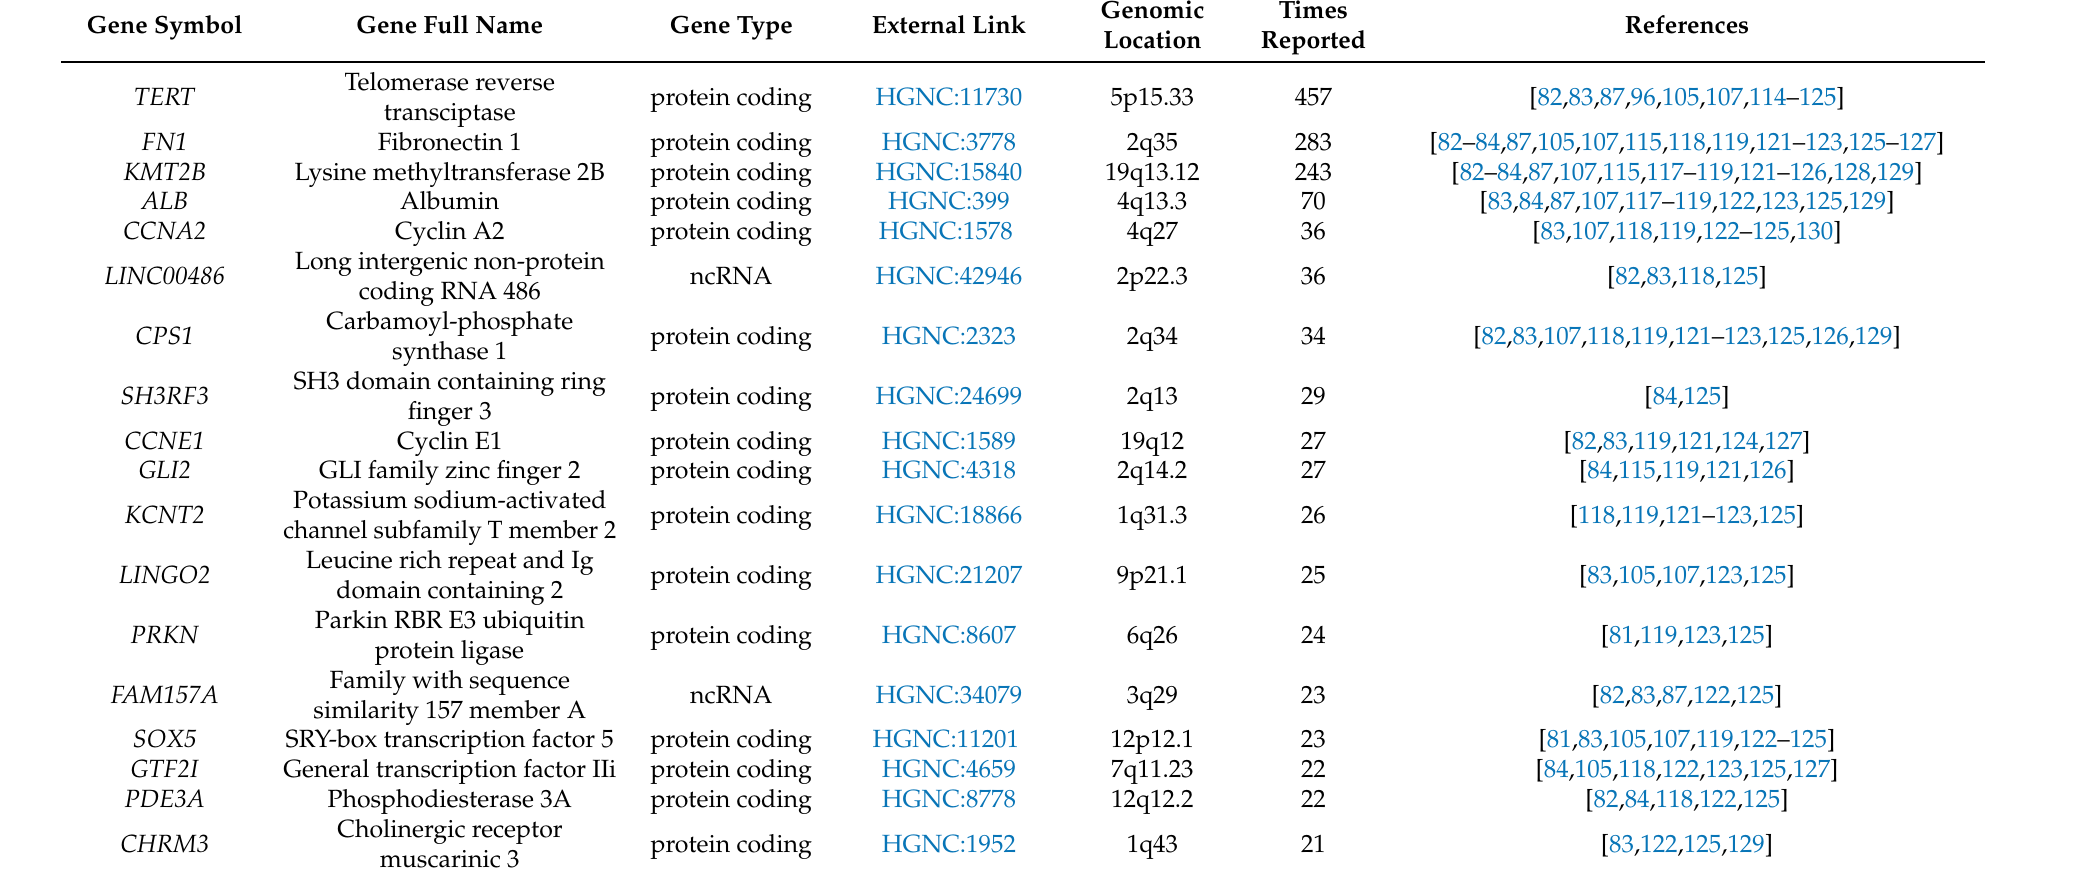
Table 1. The main target human genes affected by >20 reported HBV